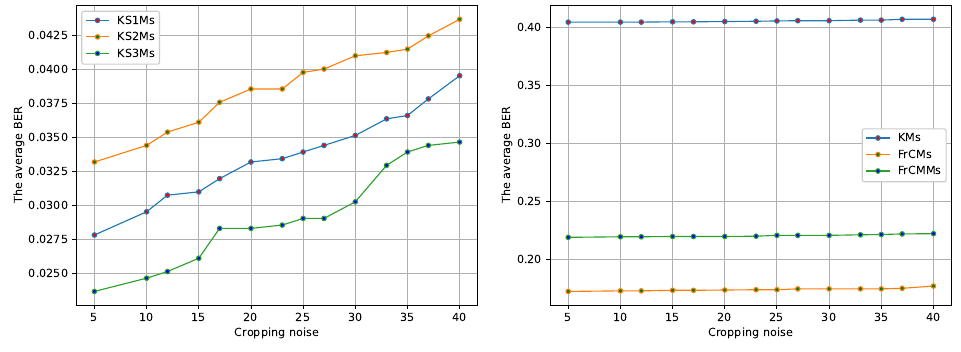
Figure 6. Cropping